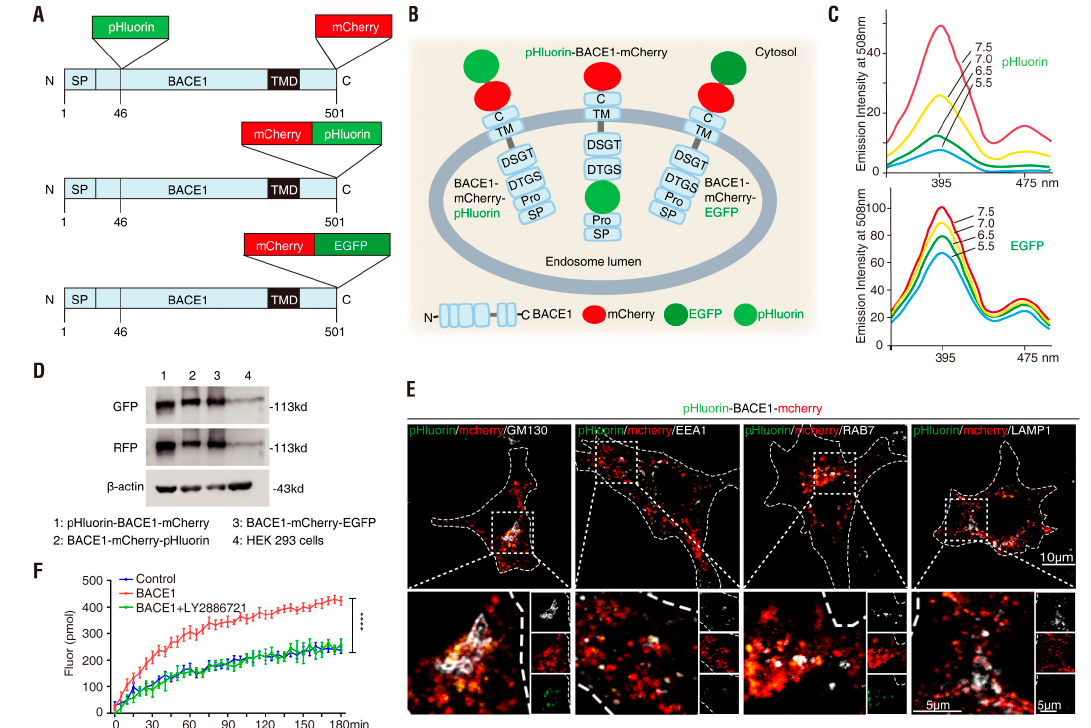
Figure 1. Generation of β‐ site APP cleaving enzyme 1 (BACE1) fusion proteins ( A ) Schematic of the linear structure of the three BACE1 expression plasmids. N, N terminal; C, C terminal; SP, BACE1 signal peptide; TMD, transmembrane domain; pHluorin and enhanced green fluorescent protein (EGFP), pH-sensitive green fluorescent protein; mCherry, pH-insensitive red fluorescent protein. ( B ) Schematic of the three BACE1 fusion proteins in the endosomal lumen. ( C ) Fluorescence excitation spectra of ecliptic pHluorin and EGFP (adapted from Gero Miesenbock) [47]. ( D ) Western blot analysis of HEK293 cells transfected with the indicated plasmids. ( E ) NLT cells expressing pHluorin-BACE1-mCherry (red and green) and BFP (blue) were immunostained with the subcellular markers: GM130, EEA1, Rab7 and LAMP1 (white). Scale bar, 10 µ m or 5 µ m. ( F ) BACE1 activity of GFP (Control) and pHluorin ‐ BACE1 ‐ mCherry (BACE1) with or without BACE1 inhibitor (LY2886721) in HEK293 cells. Data was shown as mean ± SEM ( n = 8 from three independent experiments). Significance was calculated with two ‐ way ANOVA with LSD post hoc test; **** p < 0.0001